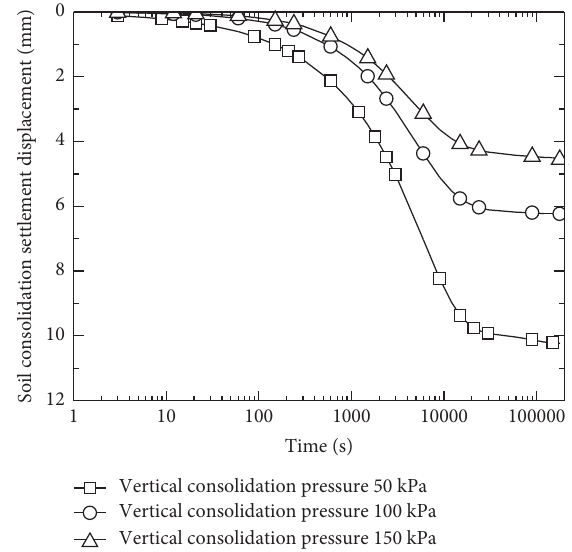
Figure 9: Displacement-time curves for soil consolidation